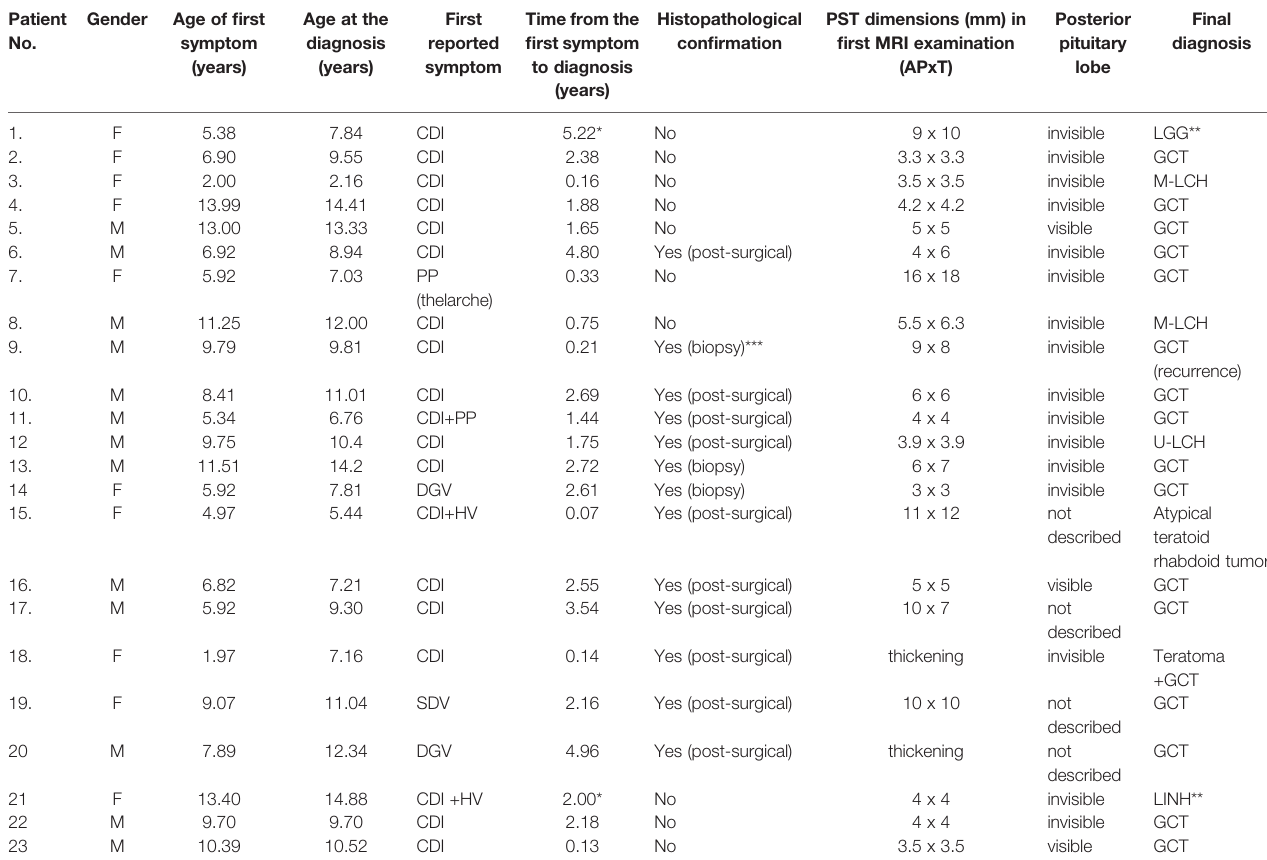
TABLE 1 | Characteristics of the group. Patient